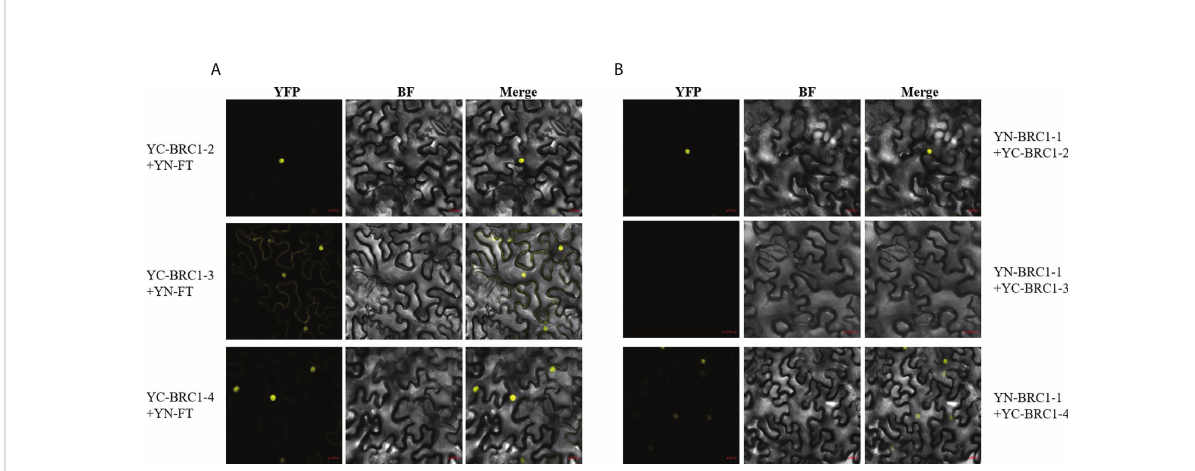
FIGURE 5 Detections of three BjuBRC1 homologous proteins interact with BjuFT or each other in vivo. (A) BiFC assays between three BjuBRC1 proteins and BjuFT (B) BiFC assays between BjuBRC1-1 and BjuBRC1-2, BjuBRC1-3, or BjuBRC1-4. YFP, YFP fl uorescence; BF, bright- fi eld; Merged, merged image of YFP and BF.